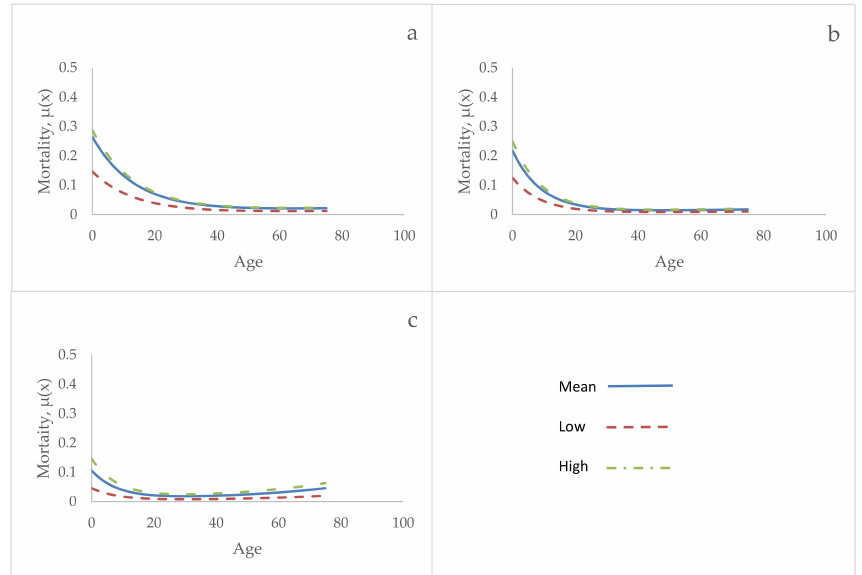
Figure 2. Age trajectories of mortality as function of di ff erent levels of growth (mean, low (2.5th percentile) and high (97.5 th percentile)) at sites 1–3 ( a – c ) using the Gompertz bathub model. Mortality is presented from germination to the age where the population from the site with the lowest mortality (site 2) reaches 1% of its original size (Figure A1). Mean = 0.47, − 0.016, − 1.14, Low = − 4.53, − 4.71, − 8.25, High = 1.16, 1.24, 1.57 mm / year at sites 1–3,